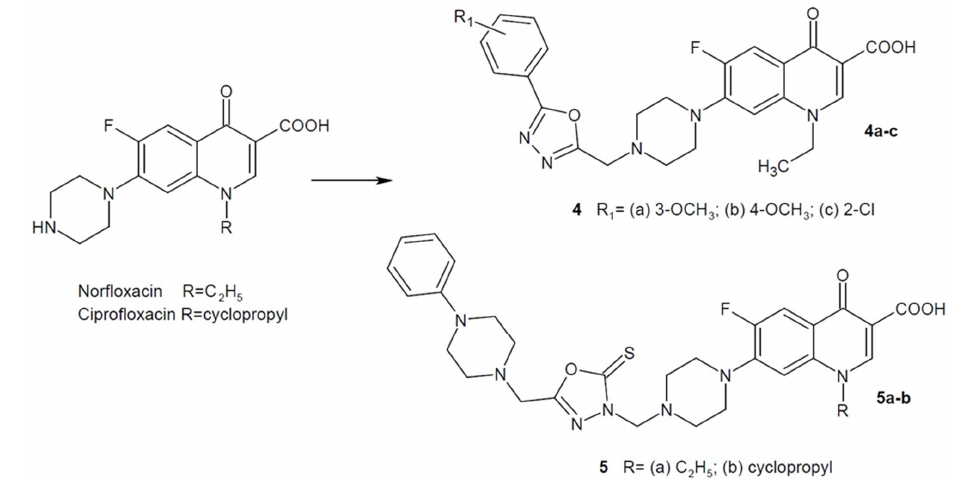
Figure 3. 1,3,4-oxadiazole hybrids of fluoroquinolone with antibacterial